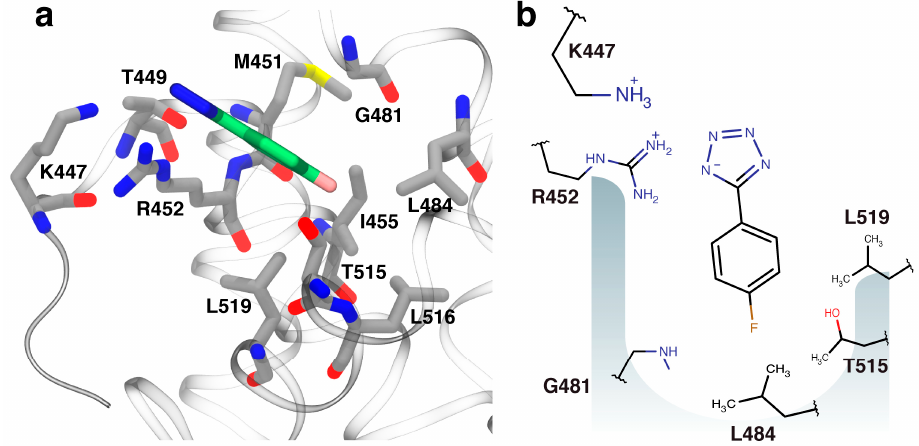
Figure 2. Modeled orientation of fragment 4 . ( a ) The docked orientation of fragment 4 (green carbon atoms) in the single-stranded DNA-binding (SSB)-Ct binding pocket of DnaGC (gray carbon atoms). ( b ) A schematic representation of interactions between fragment 4 and its binding pocket. In all structural figures, the protein was visualized using visual molecular dynamics (VMD) [31].